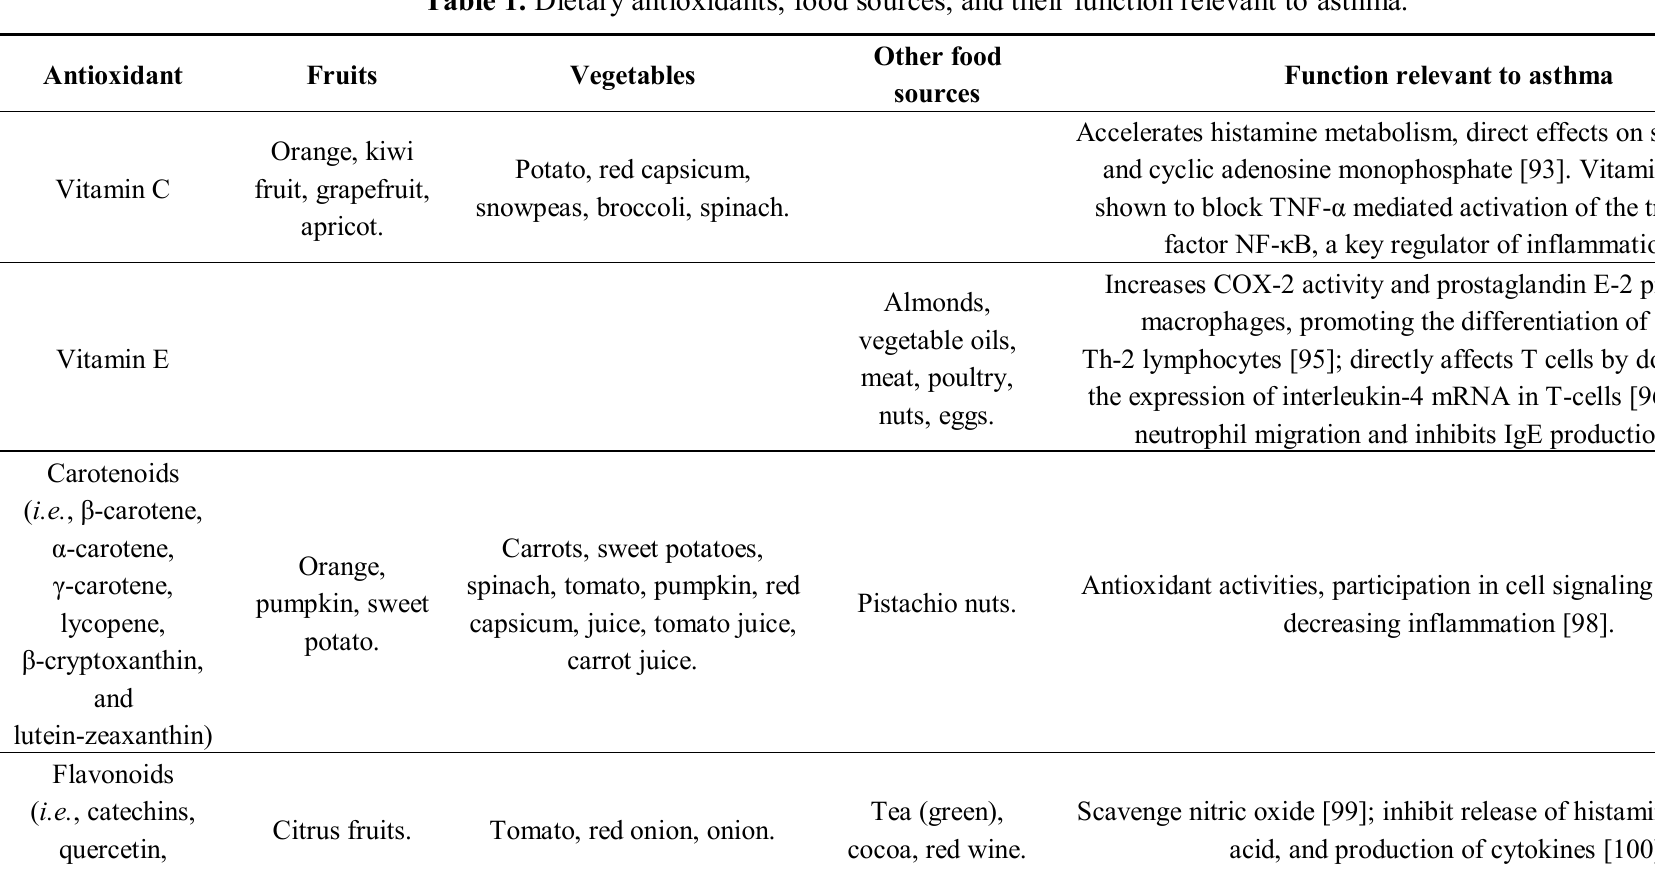
Table 1. Dietary antioxidants, food sources, and their function relevant to